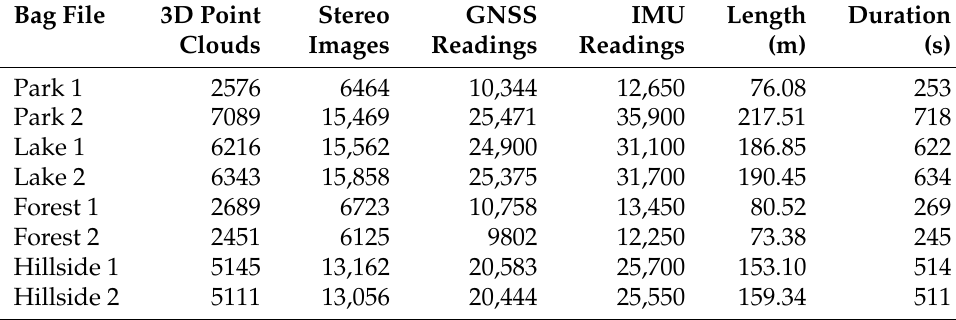
Table 4. Numerical information of the eight bag